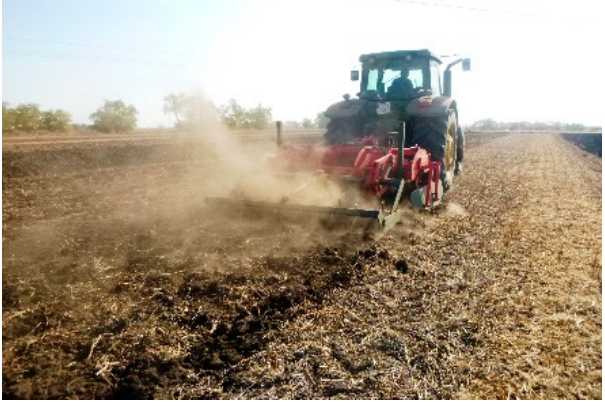
Figure 3. Loosening at JTEF (Source: Igor Dekemati).